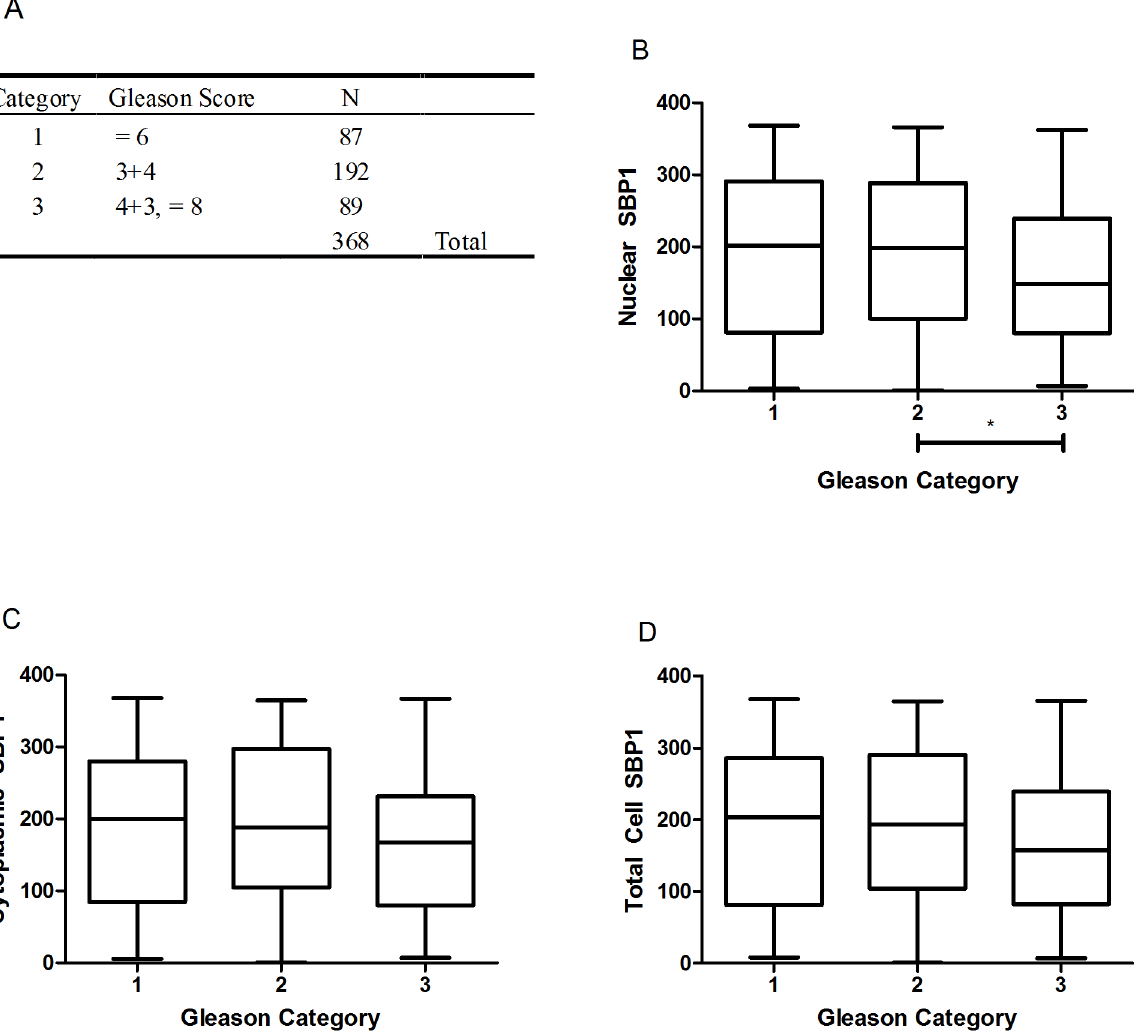
Fig 2. Lower SBP1 levels in the nucleus are significantly associated with advanced prostate cancer. Patients in the prostate cancer outcome tissue microarray were distributed into three categories (Gleason Category) based on Gleason score (A). Mean quantified tissue SBP1 was ranked for all patients and assigned a score from 1 – 368 based on relative SBP1 levels where the patient with the lowest tissue SBP1 received a score of 1, and the patient with the highest SBP1 levels received a score of 368. Box-and-whisker plots indicate the range of scores from patients in each category (vertical lines) and the range of the first and third quartile in each category (boxes). The horizontal line inside the box indicates the median. The association between SBP1 and Gleason Category was determined using SBP1 in the nucleus (B), cytoplasm (C) and total cell